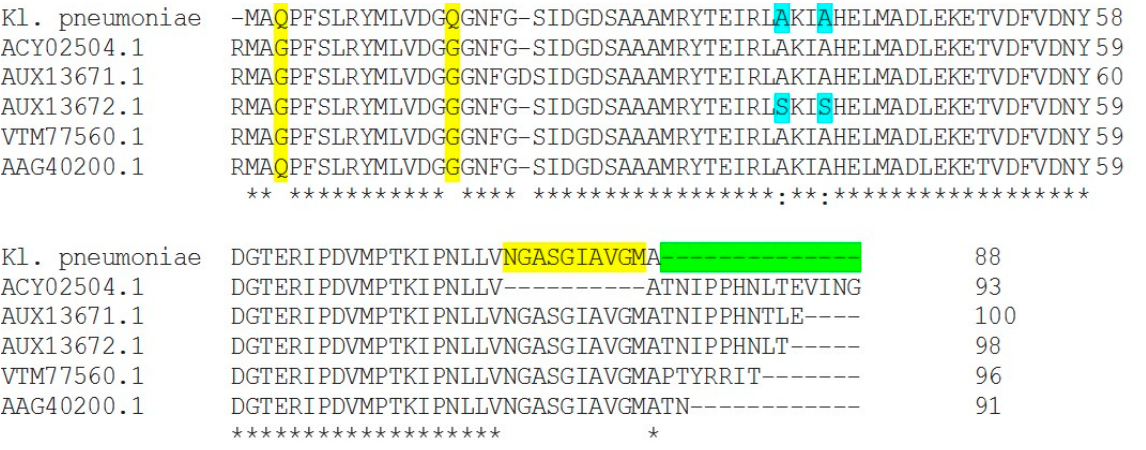
Figure 4. Amino Acid Multiple Sequence Alignment of gyrA (DNA gyrase subunit A) gene mutations in ciprofloxacin-resistant Klebsiella pneumoniae clinical isolate (Kp8) compared with another gyrA gene in NCBI database, mutation by deletion from position 75 to 88 of QRDR. The alignment sequence was performed using Clustal W2 sequence alignment. Different colors indicates the difference in sequence aligment, red color indicates genes codon in our clinical isolte deleted in compared gene bank isolates, green colors indicates genes codon deleted in out tested isolates, “*” conserved sequences indicates amino acid have single, fully conserved residue (identical); “:” blue color indicates non-conservative mutations that amino acid have different properties.